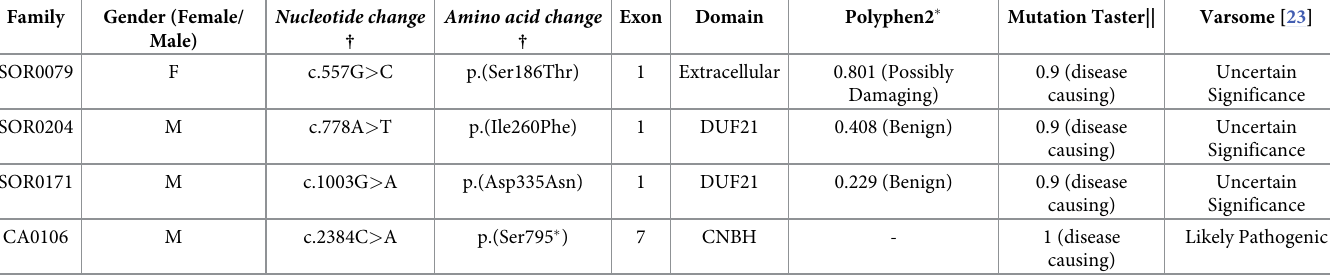
Table 2. Novel CNNM2 variants and their in silico pathogenicity prediction identified in this study. Family Gender (Female/